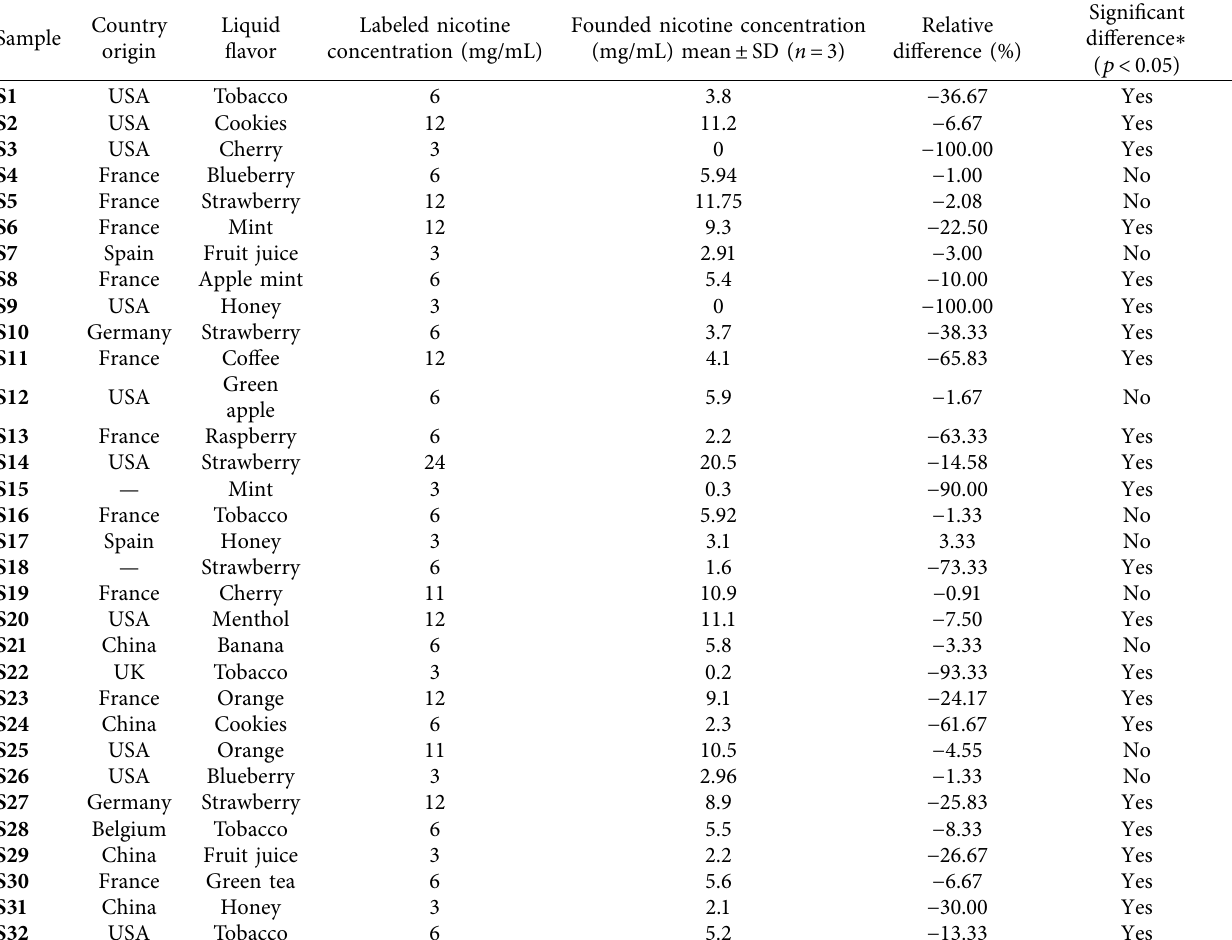
Table 2: Comparison of labeled and determined nicotine concentrations in 32 commercial liquids of e-cigarette ( n � 32).